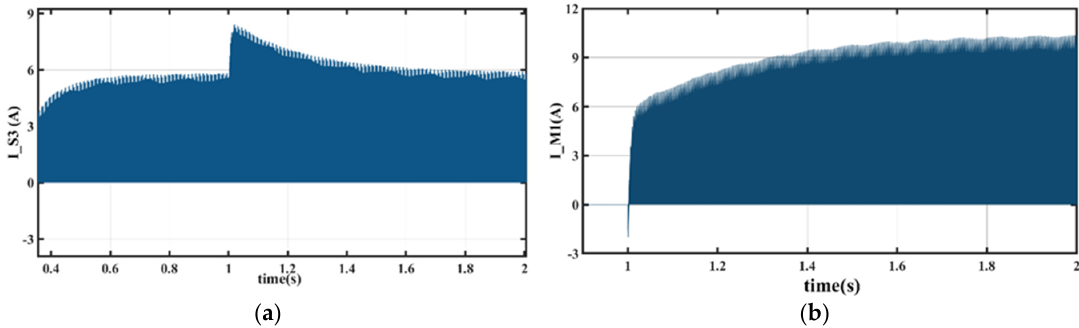
Figure 12. Simulation results for the proposed fault–tolerant topology with the proposed fault diagnosis algorithm when an OCF occurs on the switch S 1 in forward mode: ( a ) current of switch S 3; ( b ) current of switch M 1.